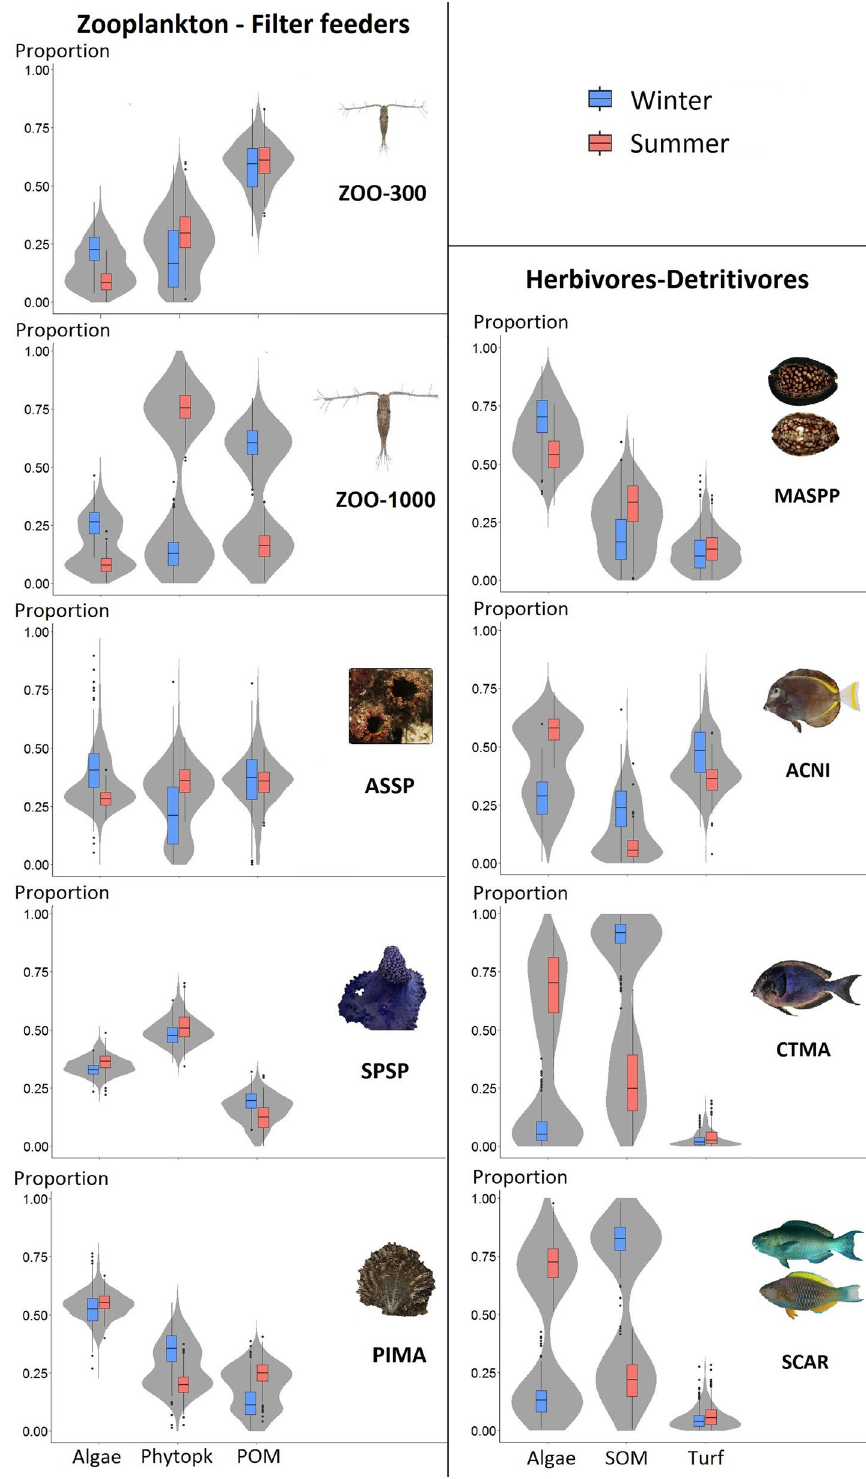
Figure 2. Relative proportions of the different OM sources for filter-feeders and zooplankton (left panel) and for herbivore-detritivores (right panel), based on SIAR mixing model outputs. Phytopk: Phytoplankton; POM: particulate organic matter; SOM: sedimentary organic matter. Violin plots represent the posterior distribution shape of the data (density estimation) in grey; boxplots represent median, interquartile ranges (red and blue boxes, depending on season), 95% credibility intervals (thin line) and outliers (black dots). ZOO-300: zooplankton 300–500 μm, ZOO-1000: zooplankton 1000–2000 μm, ASSP: ascidians, SPSP: Spheciospongia sp., PIMA: Pinctada margaritifera, ACNI: Acanthurus nigricans , CTMA: Ctenochaetus marginatus , SCAR: Scarinae ( Scarus koputea and S. rubroviolaceus ), MASPP: Mauritia